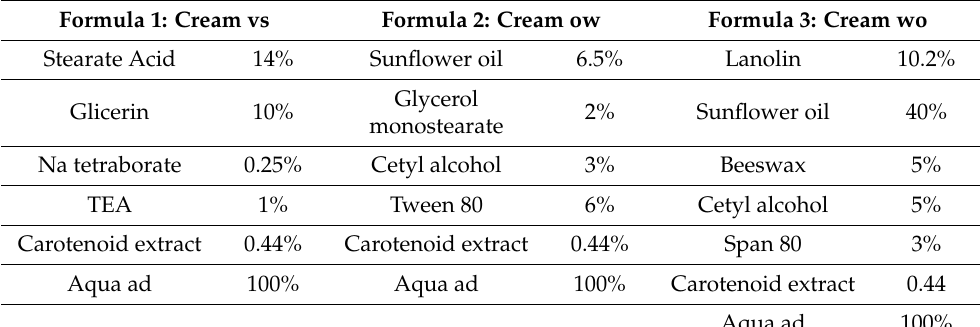
Table 1. Cream formulas of carotenoid extract V. salarius strain